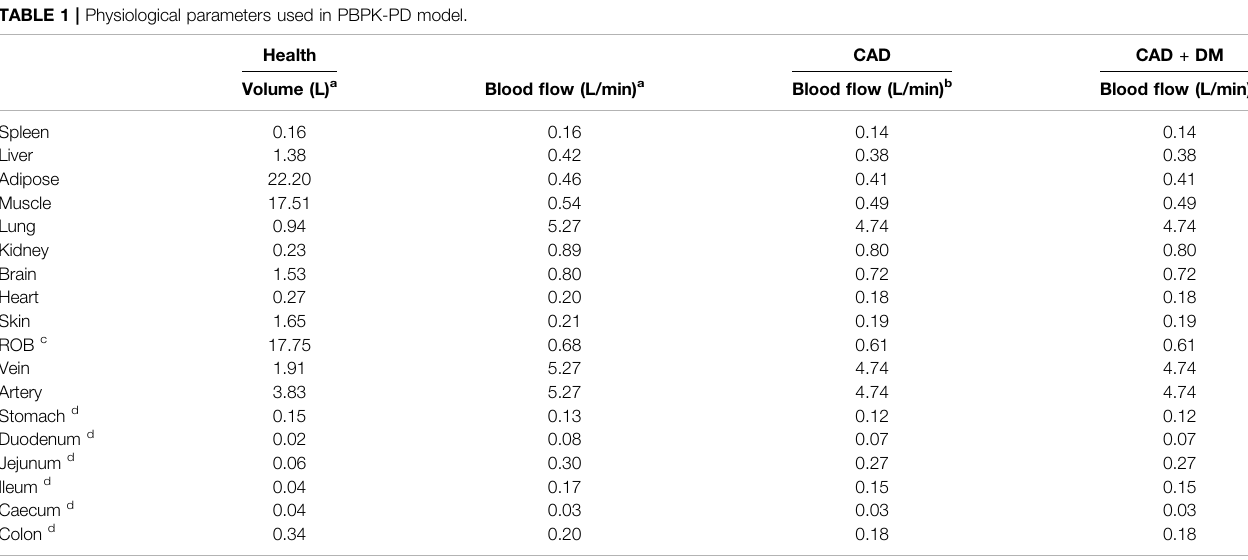
TABLE 1 | Physiological parameters used in PBPK-PD model.